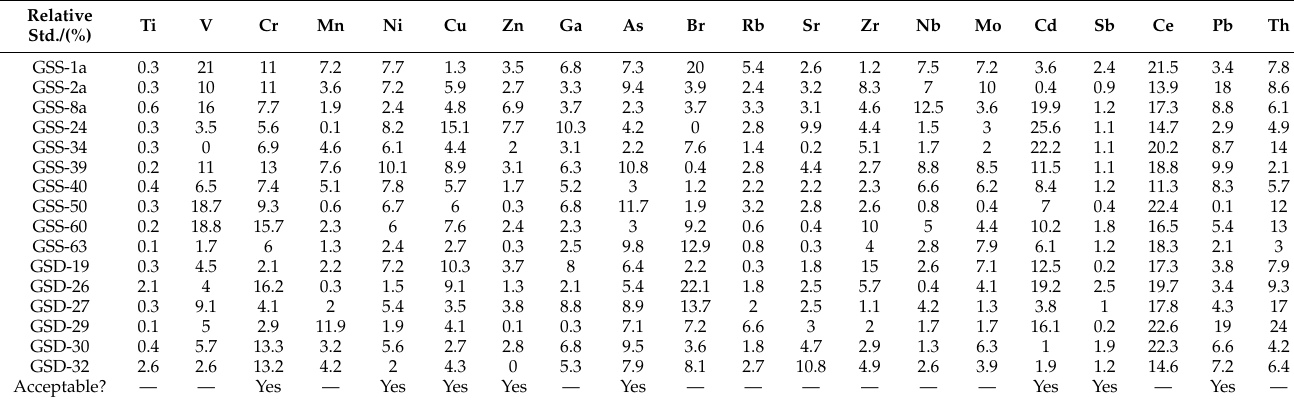
Table 2. The precision of the MED-XRF